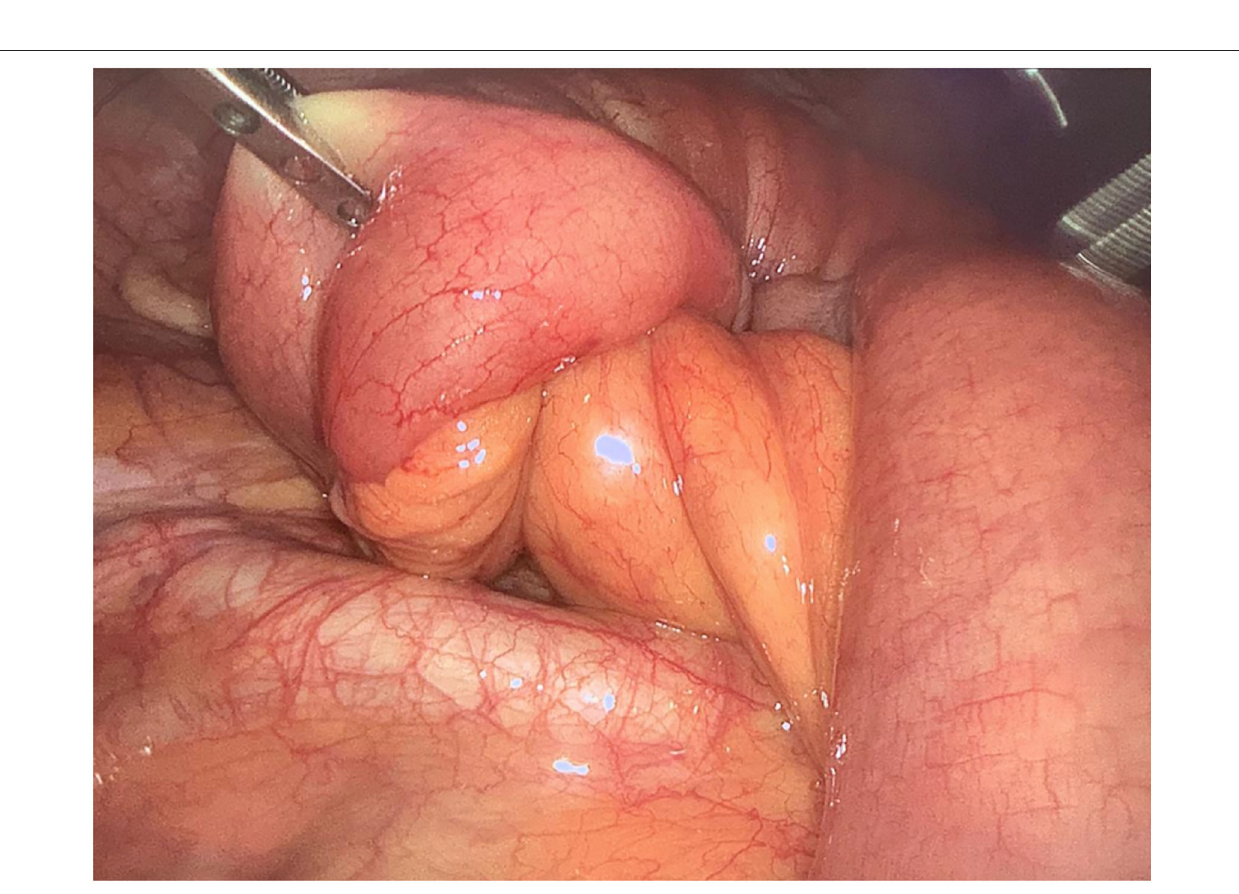
Frontiers in Surgery |